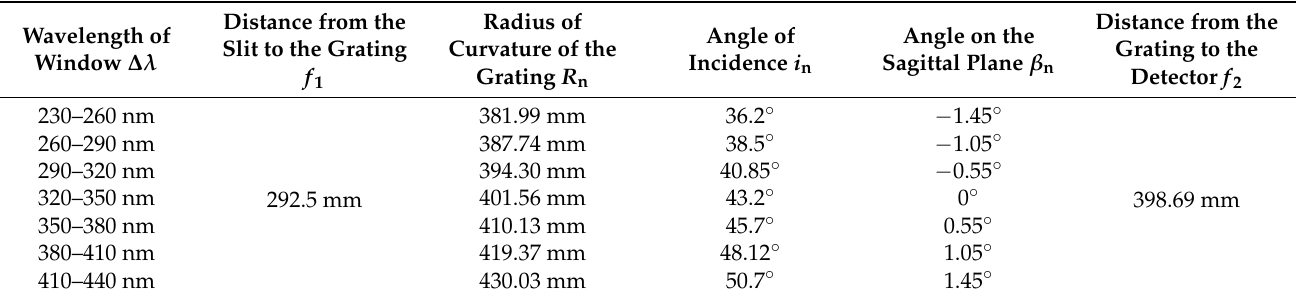
Table 1. Main parameters of the optical structure.